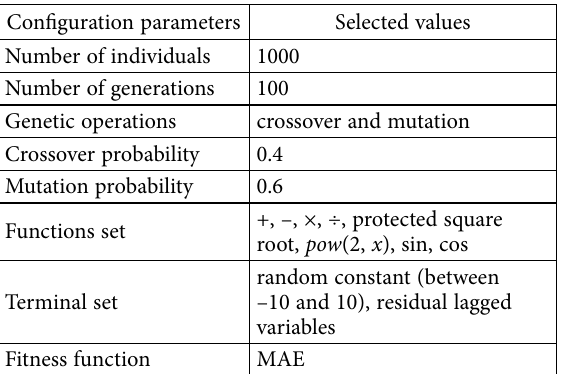
Table 6. The configuration parameters of the GP model